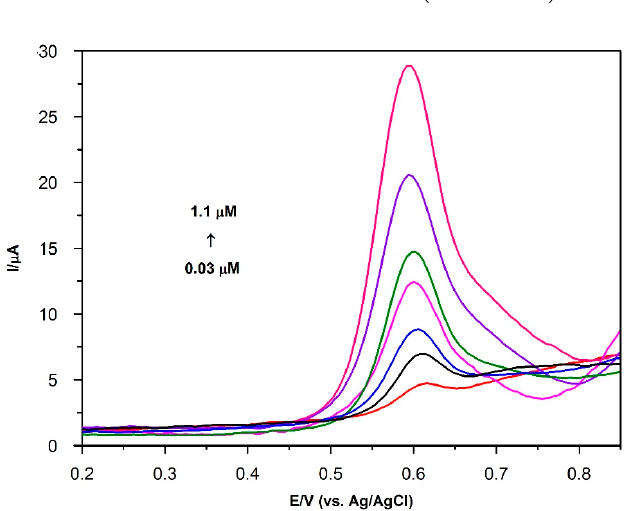
Figure 9. SWAdSV curves of BPA at AuNP/PVP modified PGE in 0.1 M PBS containing 0.03–1.10 μ M. Conditions: pH 7.0; frequency: 50 Hz; step amplitude: 40 mV; pulse amplitude: 5 mV; E dep : − 0.1 V; t dep : 120 s.